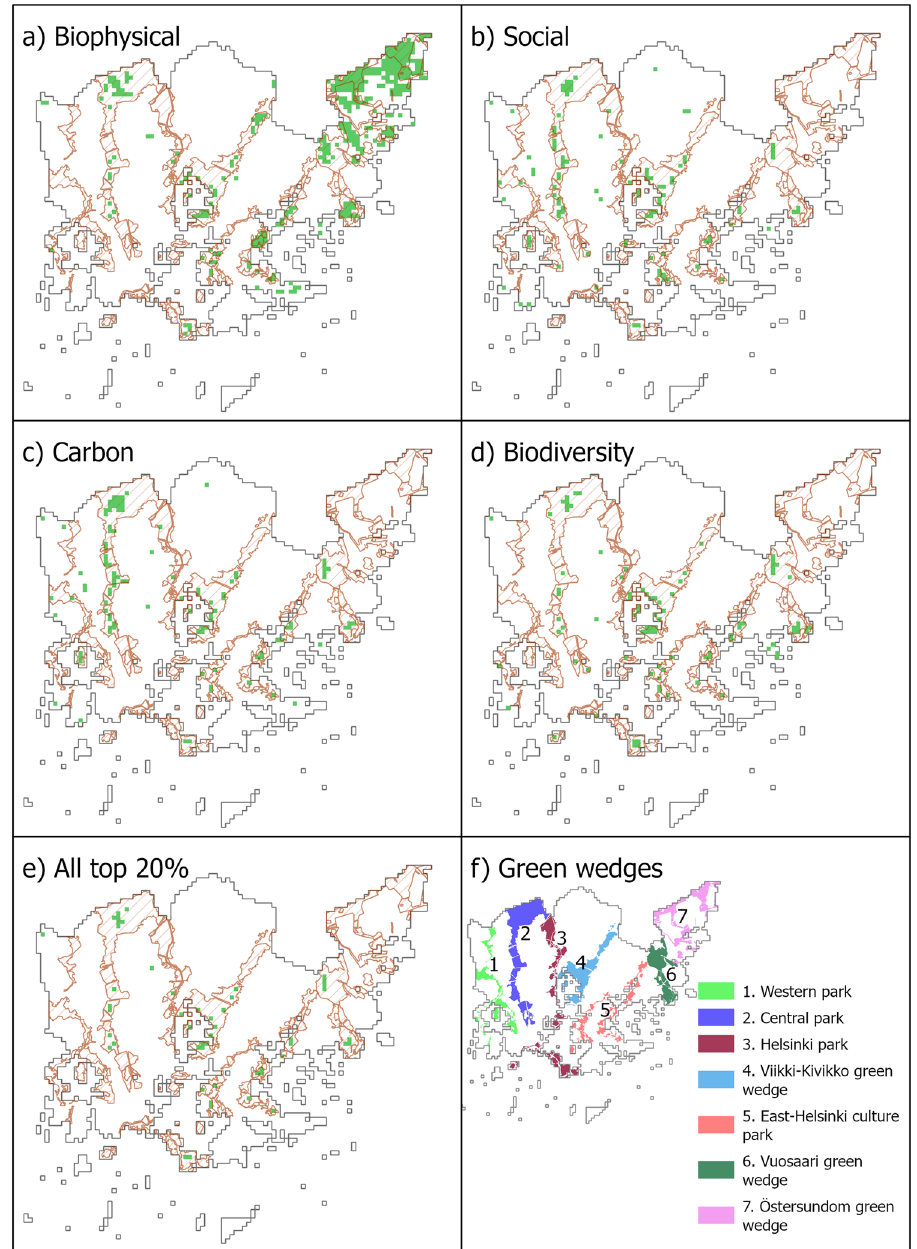
Fig. 4 Management scenarios for nature-based solutions. Four synergies a biophysical value maximiser (overlap of top 20% Carbon Flux & Biodiversity), b SV maximiser (overlap of top 20% SV Carbon & SV Biodiversity), c carbon maximiser (overlap of top 20% Carbon and SV Carbon), d biodiversity maximiser (overlap of top 20% biodiversity & SV Biodiversity, e carbon and biodiversity biophysical and SV balancer (overlap of top 20%